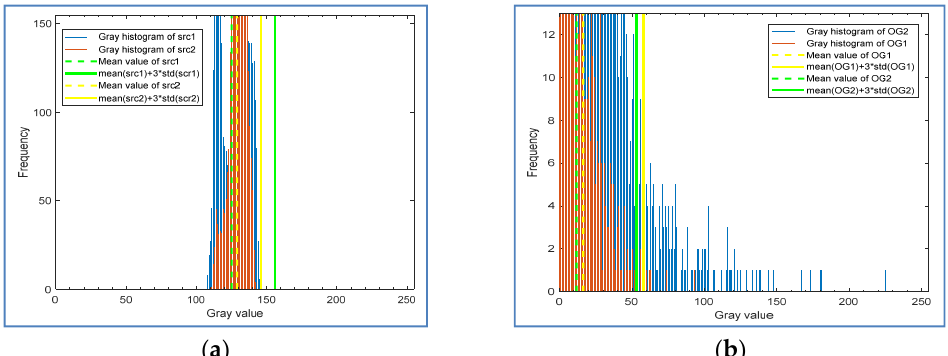
Figure 10. Histogram and statistical information of two similar regions: ( a ) original images; ( b ) gradient images.